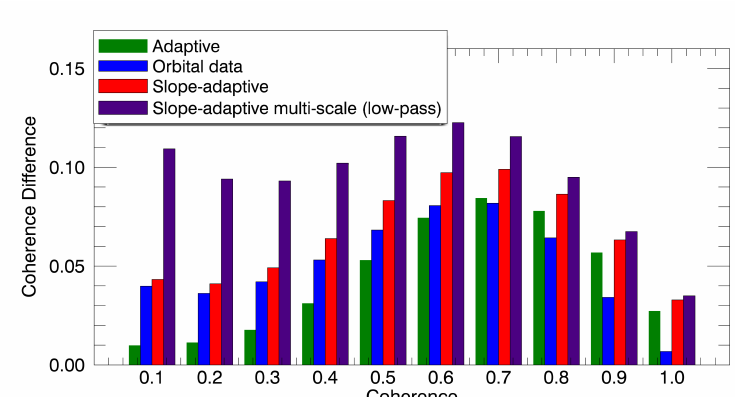
Figure 19. Coherence improvement for different intervals of coherence. Ten intervals were selected within [ 0,1 ] .